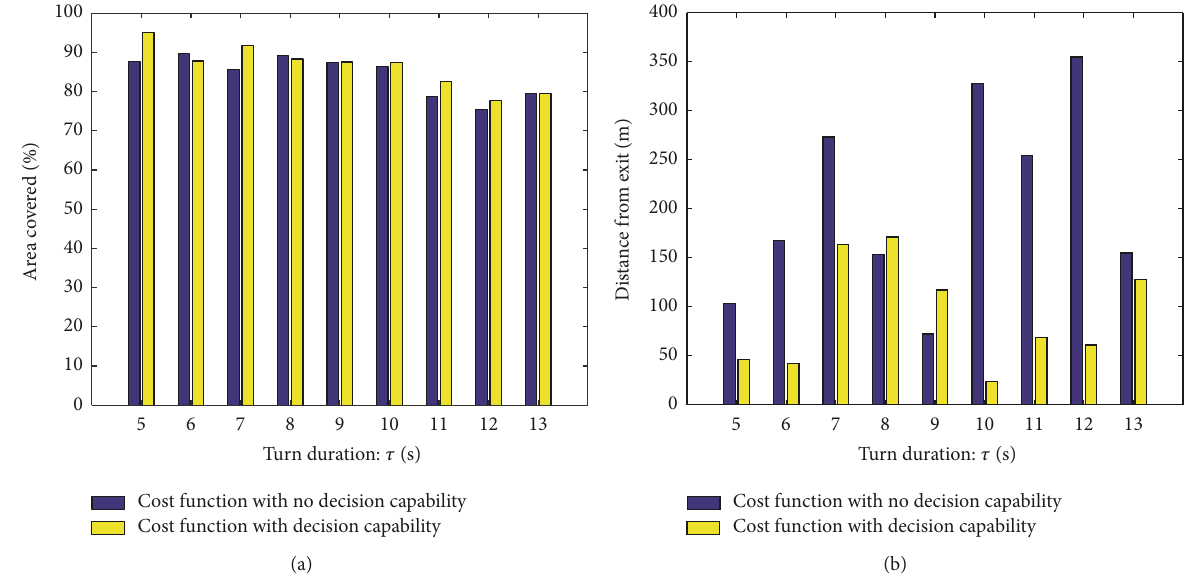
Figure 13: Performance of algorithm for no decision capability and decision capability for range of turn rates: (a) coverage performance and (b) distance from desired exit state at the end of